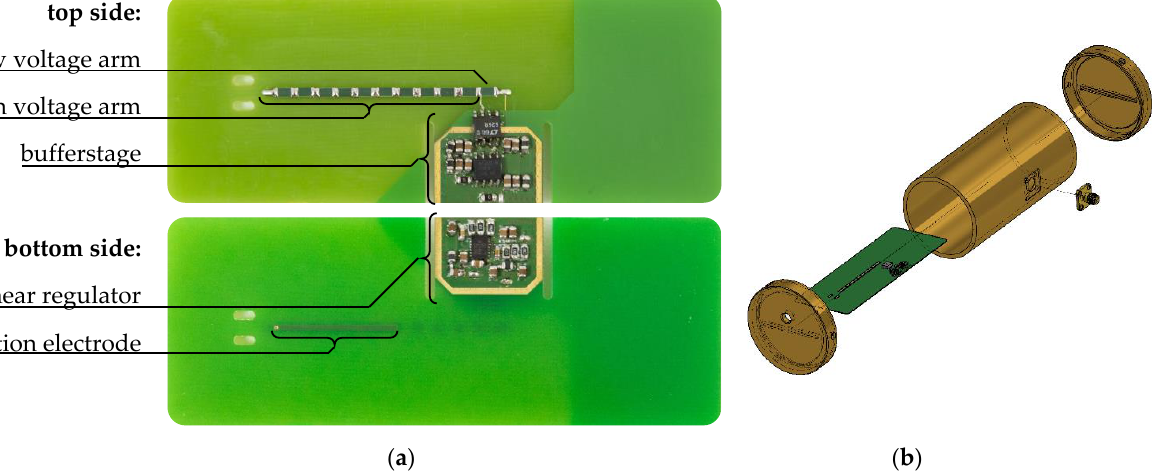
Figure 8. ( a ) The upper picture shows the top side of PCB of the assembled resistive voltage divider with the ten SMD resistors forming the HVA and the single SMD resistor for the LVA, as well as the amplifier circuit in the lower middle of the PCB. The lower picture shows the bottom side of the PCB, with the rectangular shaped compensation electrode on the left and the linear voltage regulator in the middle. ( b ) Exploded view of the complete high-voltage probe including the resistive voltage divider, the brass housing, the high-voltage connection, and the low-voltage output.